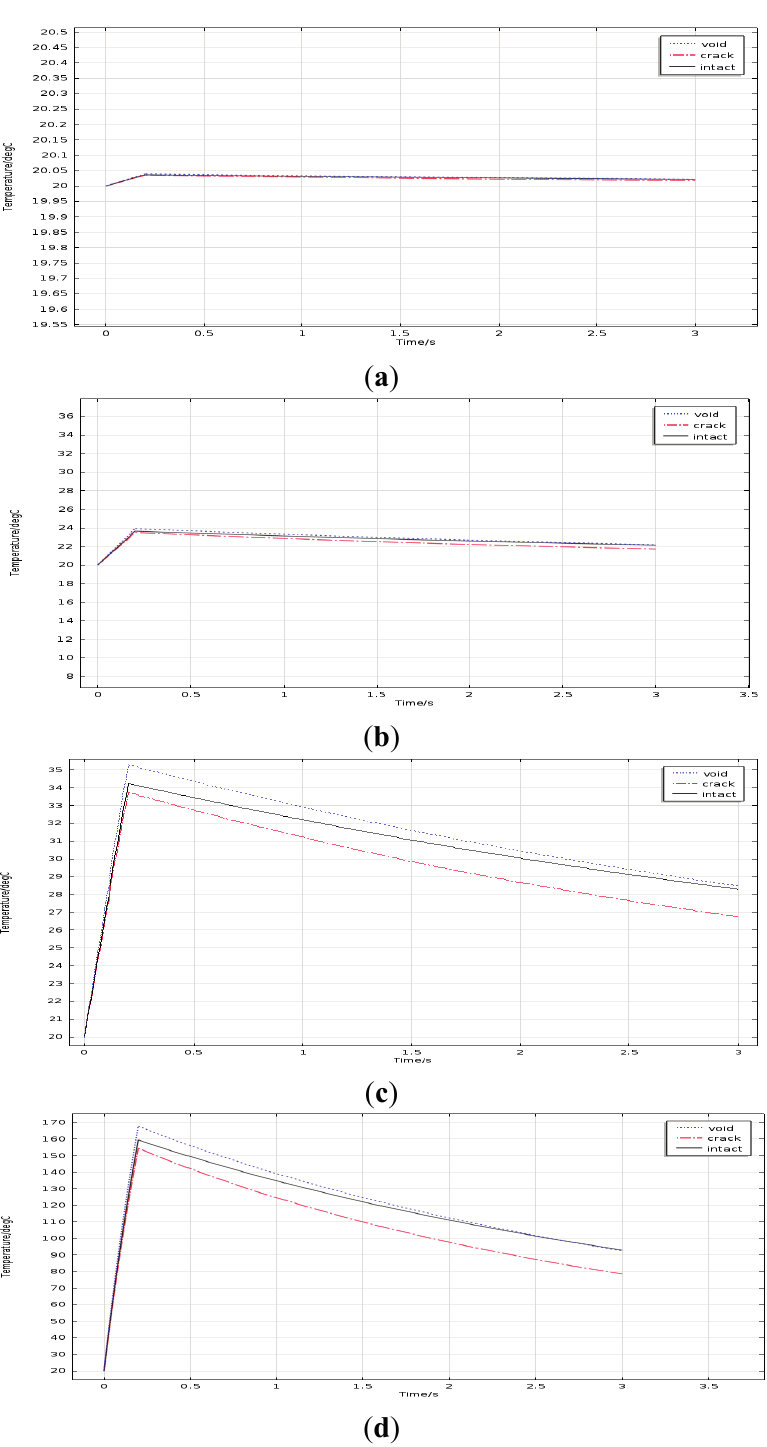
Figure 7. Temperature curves for different current density for ( a ) 6.3 × 10 5 A/m 2 ; ( b ) 6.3 × 10 6 A/m 2 ; ( c ) 1.26 × 10 7 A/m 2 ; ( d ) 4.41 × 10 7 A/m 2